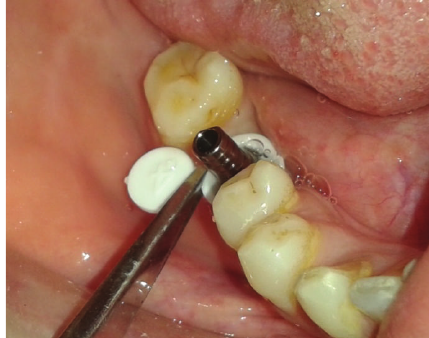
Figure 9: Definitive crown.